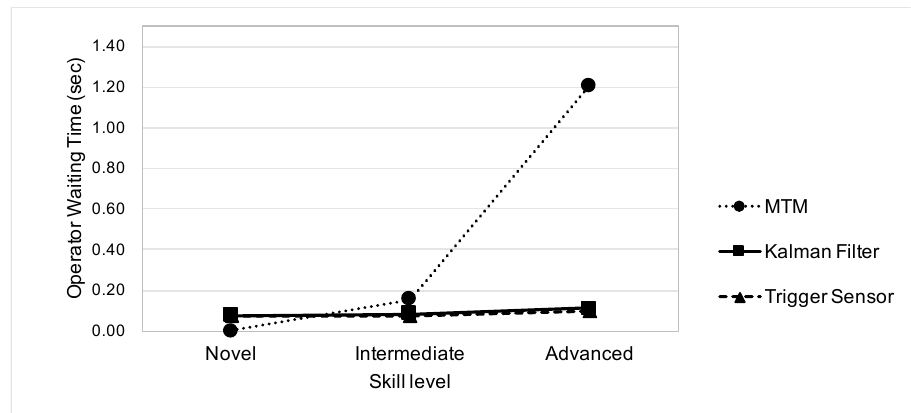
Figure 6. Average operator waiting time (OWT) for the three skill level groups and handover prediction models.